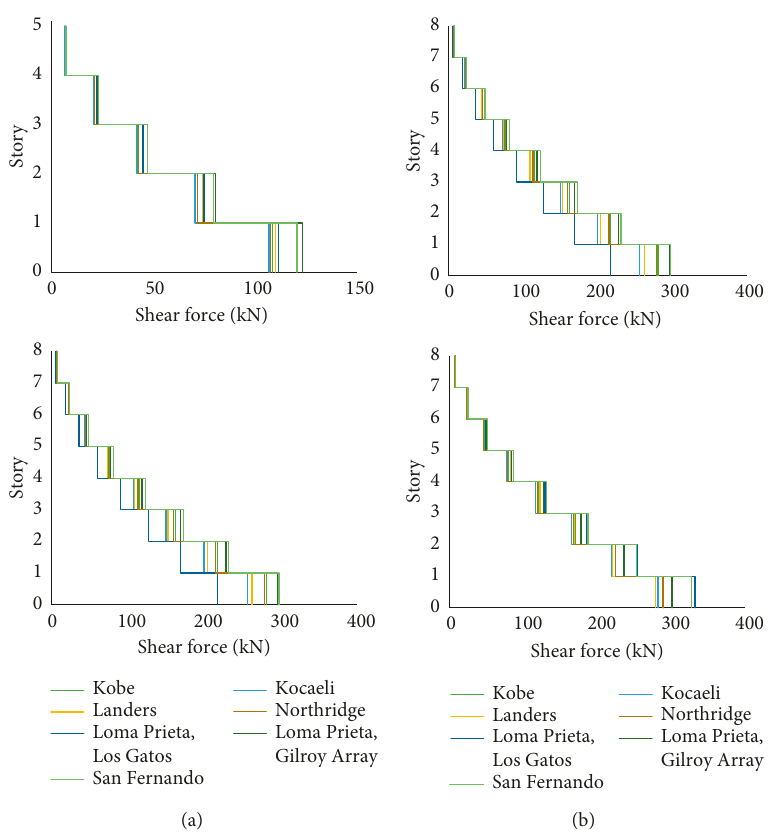
Figure 11: Shear story variations of 5- and 8-story frames under near-field records. (a) Soil type II and (b) soil type III.